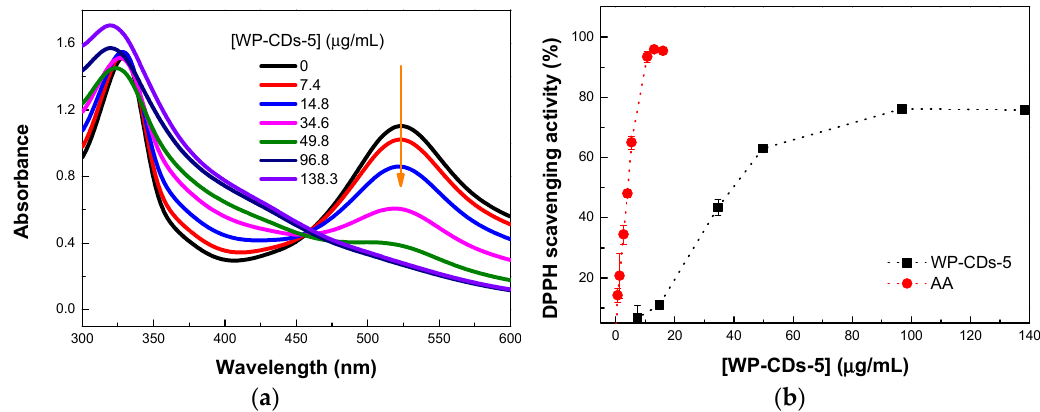
Figure 11. ( a ) Absorption spectra of DPPH in ethanol (0.127 mM) on increasing the concentration of WP-CDs-5 in the range 7.4–138 μ g/mL and ( b ) the scavenging activity of DPPH radicals by WP-CDs-5, having AA for comparison (absorbance monitored at 520 nm). Dotted lines drawn as an eye guide.